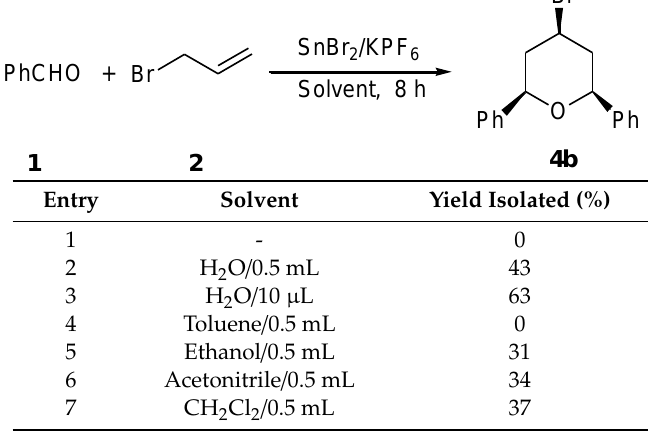
Table 5. Reaction of benzaldehyde (1) with allyl bromide (2) promoted by KPF 6.